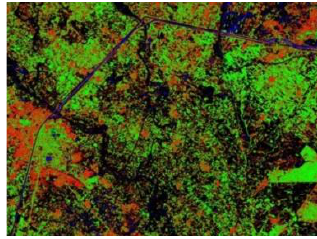
Fig. 11 Maximum likelihood classified PALSAR data